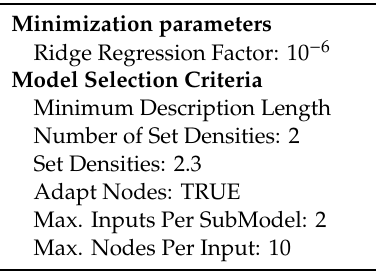
Table 4. Training parameters setting with FormRules ®